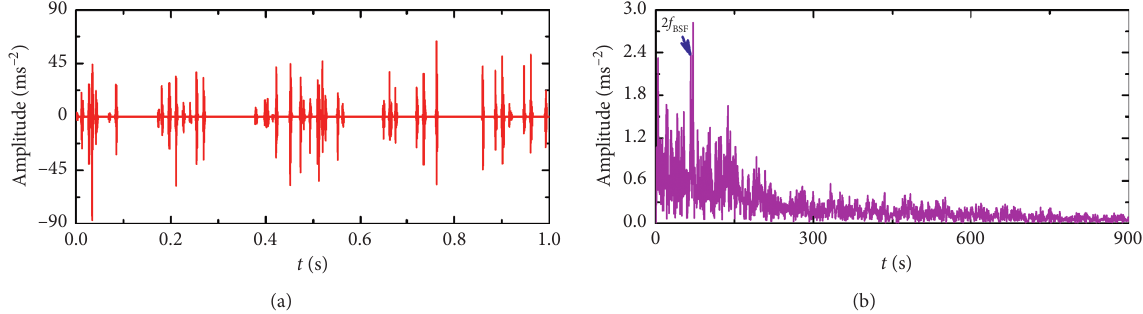
Figure 20: Results obtained by SBAKW: (a) extracted signal and (b) Hilbert envelope spectrum of signal in (a).